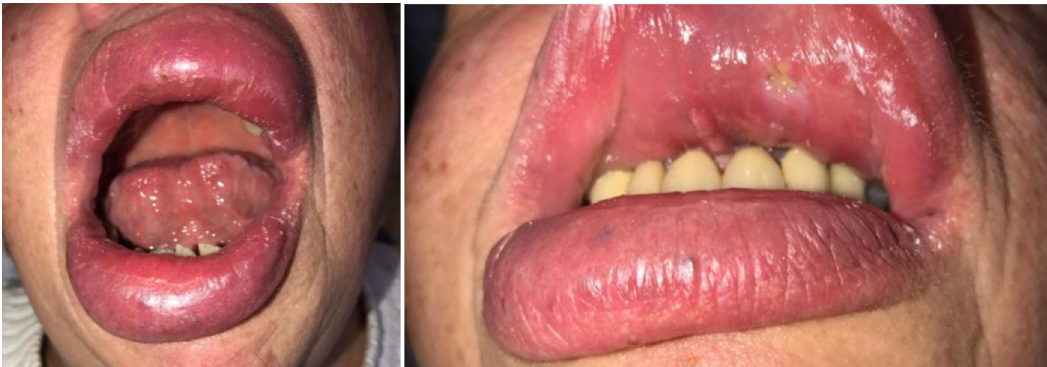
Fig. 1. Swollen lips with a predominant area in the upper left lip, and intraoral fi stula with a yellowish aspect of the lesion.